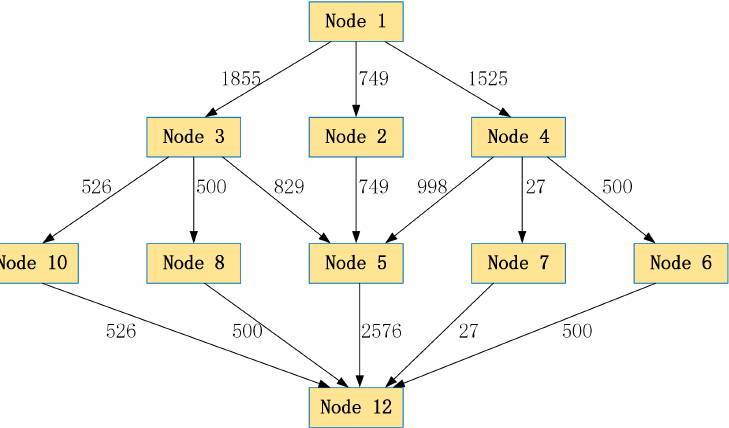
Figure 6. Network flow diagram of community evacuation path planning calculated by Algorithm